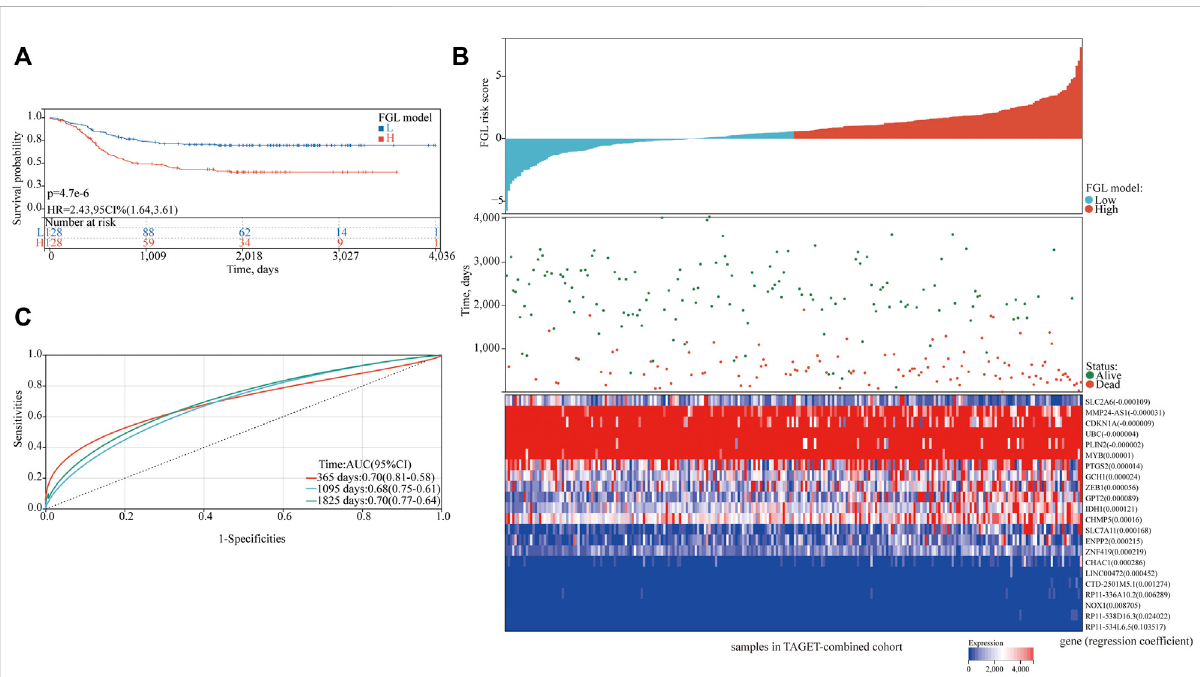
FIGURE 3 Characteristics of the patients in the TARGET-combined cohort based on the constructed FGL model. (A) Kaplan – Meier curve of the high-risk and low-risk groups of the combination set showed differences in survival rate. (B) Distribution of risk score, survival status of each patient, and heatmap expression of 22 ferroptosis-related signatures in high-risk and low-risk groups were presented. (C) Receiver operating characteristic (ROC) curves of 1-year, 3-year, and 5-year overall survival for P-AML patients of the TARGET-combined cohort based on the FGL prognostic